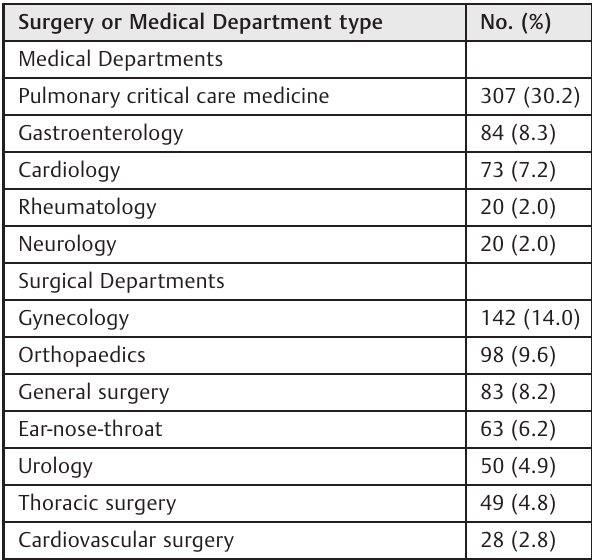
Table 2 Distribution of included patients ’ departments Surgery or Medical Department